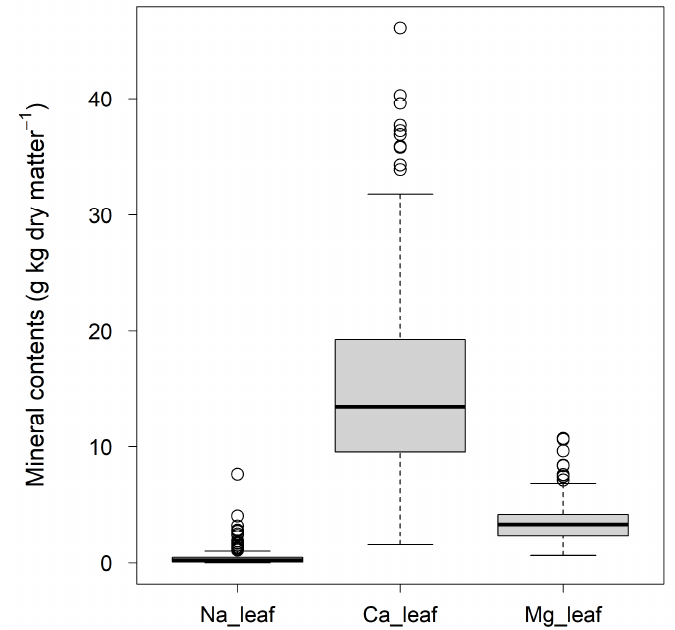
Figure 1. Boxplot of the distribution of leaf mineral contents of sika deer feed plants. Na_leaf, Ca_leaf and Mg_leaf are the Na, Ca and Mg contents per leaf dry mass, respectively.